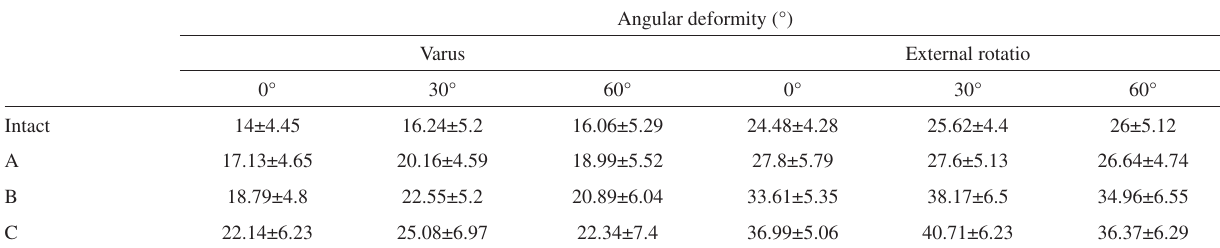
Table 1 - Angular deformity of the knee during the application of force in varus and in external rotation (mean ± standard